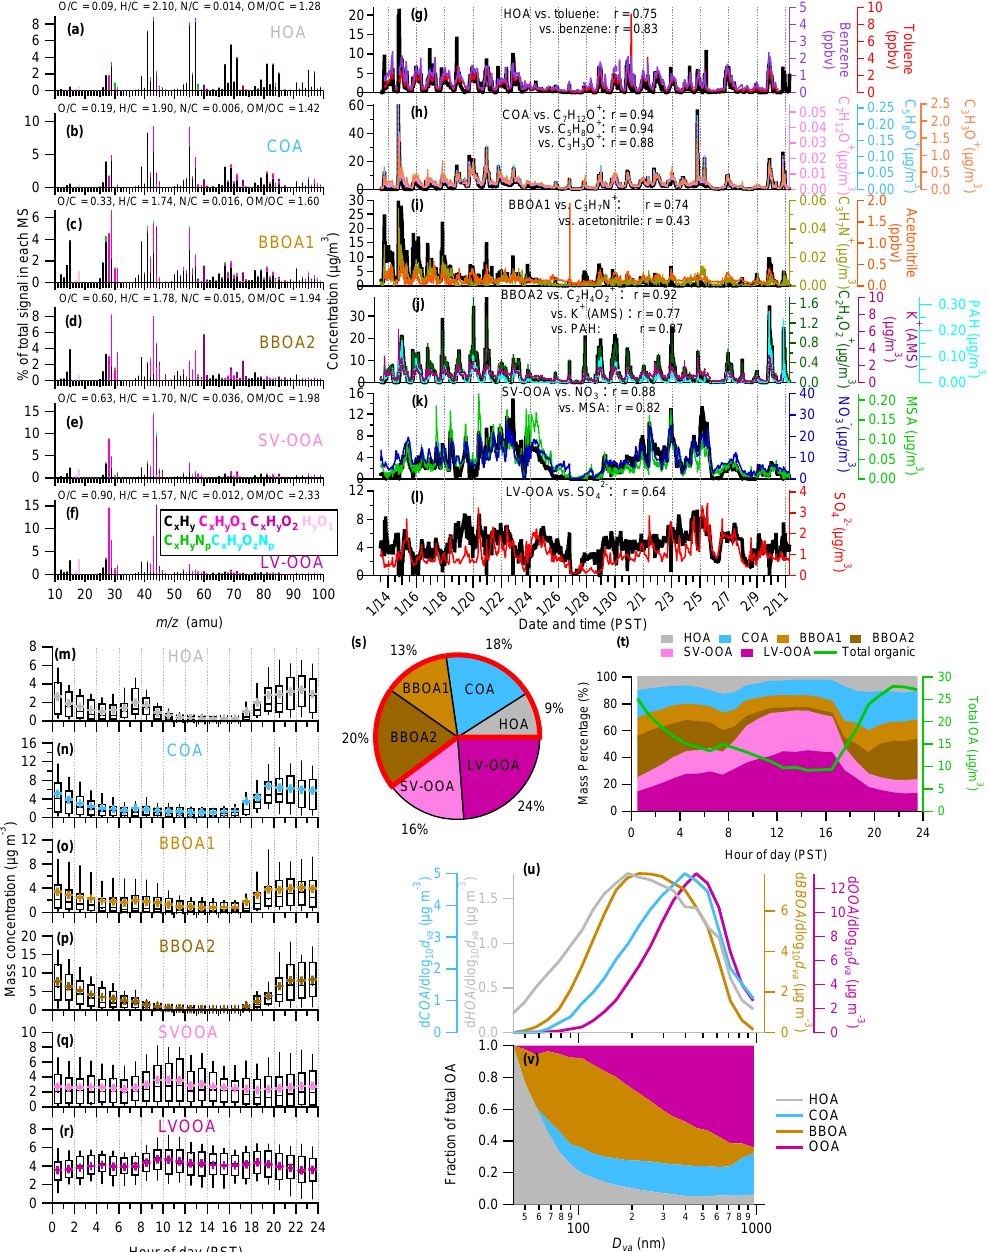
Figure 6. Overview of the results from positive matrix factorization (PMF) analysis including high-resolution mass spectra of the (a) hydrocarbon-like OA (HOA), (b) cooking OA (COA), (c) biomass burning OA 1 (BBOA1), (d) biomass burning OA 2 (BBOA2), (e) semivolatile oxygenated OA (SV-OOA), and (f) low-volatility oxygenated OA (LV-OOA) colored by different ion families; (g–l) time series of each of the OA factors and various tracer species; (m–r) average diurnal profiles of each of the OA factors (the 90th and 10th percentiles are denoted by the whiskers above and below the boxes, the 75th and 25th percentiles are denoted by the top and bottom of the boxes, the median values are denoted by the horizontal line within the box, and the mean values are denoted by the colored markers); (s) compositional pie chart of the average fractional contribution of each of the OA factors to the total OA for the campaign. The POA factors are outlined in red. (t) Average diurnal mass fractional contribution of each of the OA factors to the total OA diurnal and the total OA mass loading; and (u) average size distributions of the OA factors where BBOA1 and BBOA2 were summed together to BBOA before performing the analysis. Similarly, SV-OOA and LV-OOA were also summed to OOA before performing the analysis. (v) Average mass fractional contributions of the OA components to the total OA mass as a function of